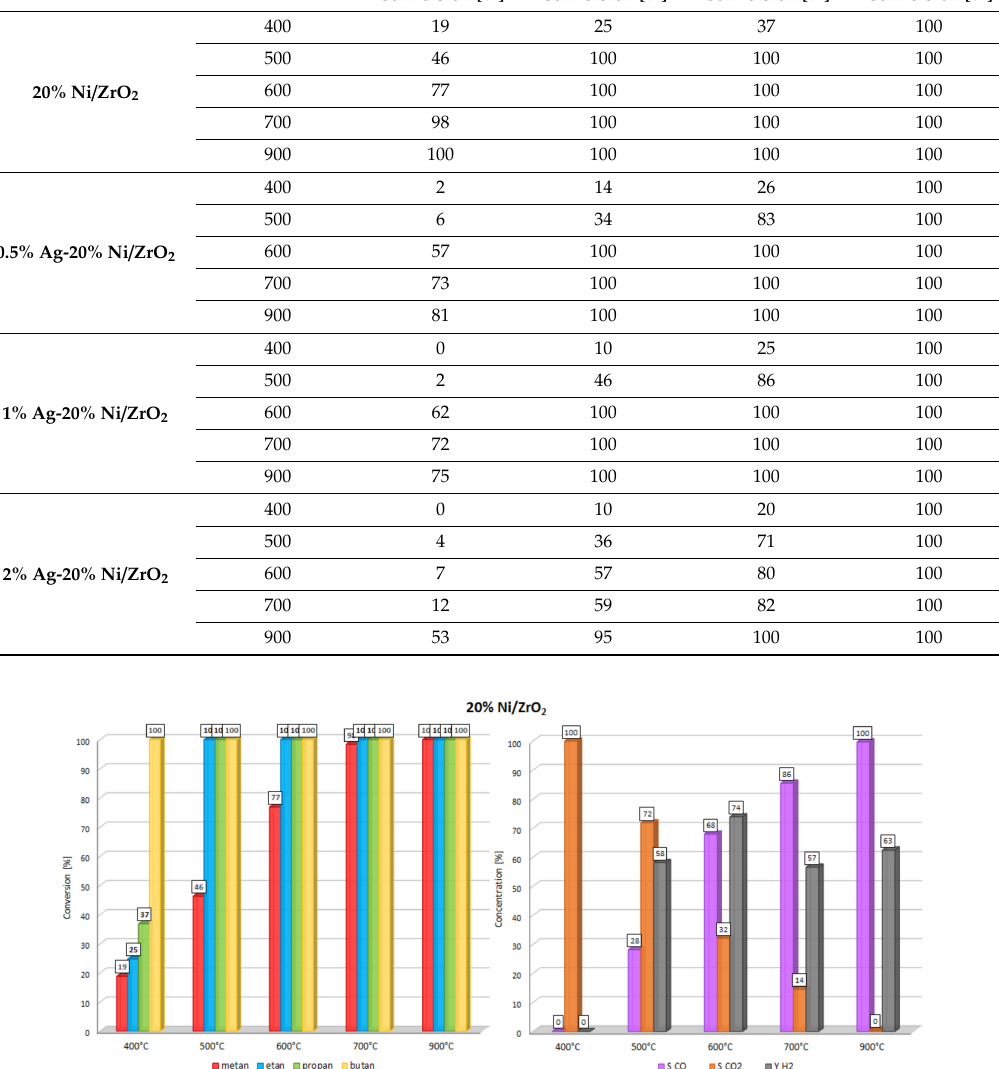
Figure 3. The activity results of the 20% Ni / ZrO 2 catalyst in OSR-LNG process.